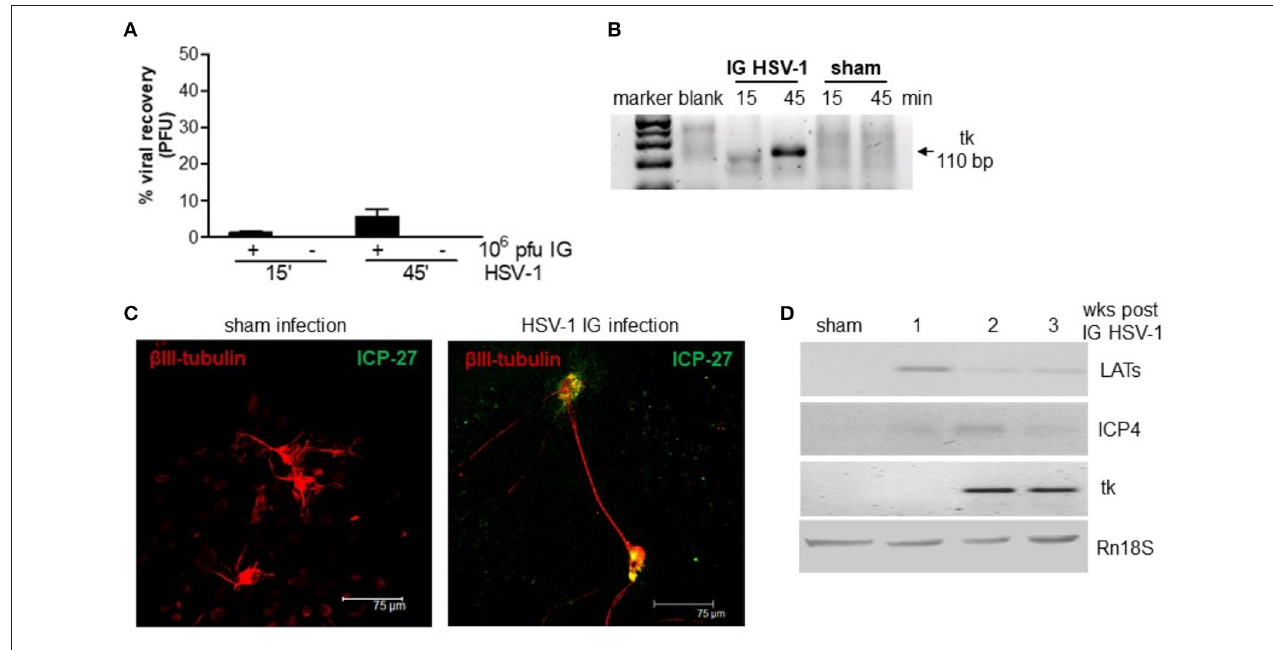
FIGURE 1 | HSV-1 infection of the ENS. (A) The content of the ileum was collected from mice at 15 and 45min post-IG inoculum with HSV-1 strain 16 (1 × 10 7 PFU). Intestinal content was co-cultured on Vero cells and plaques were counted. The number of plaques derived from Vero cells incubated with HSV-1 strain SC16 (1 × 10 7 PFU) but not injected in mice was taken as 100%. Data are represented as mean ± SEM of three separated experiments. n = 4 mice per group. (B) Total DNA was isolated from Vero cells exposed for up to 72h to content of ileum obtained from mice inoculated IG with HSV-1 or sham infected. DNA was subjected to PCR using HSV-1 tk specific primers. Representative picture of one out of three agarose gel is reported. bp: base pairs. (C) Primary enteric neurons were infected with HSV-1, fixed 36h later, and probed with anti- β -III-tubulin (red) and anti-ICP-27 (green) antibodies. Cells were imaged using a confocal microscope. Representative images are shown. (D) One, two, and three weeks post-IG inoculum of HSV-1 strain SC16, total RNA was purified from LMMP and semi-quantitative PCR was performed to evaluate the expression of HSV-1 LATs and early (ICP4, tk) mRNA transcripts. A representative experiment is shown. Rn18S was used as extraction and loading control. Sham: mice IG inoculated with Vero cell